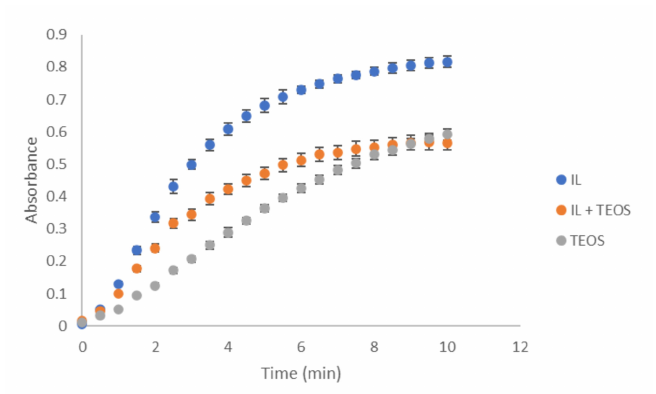
Figure 2. Kinetic study—analytical signals of derivates in solution by using the different type of sensor. NO − . concentration 1.4 mg L − 1 2